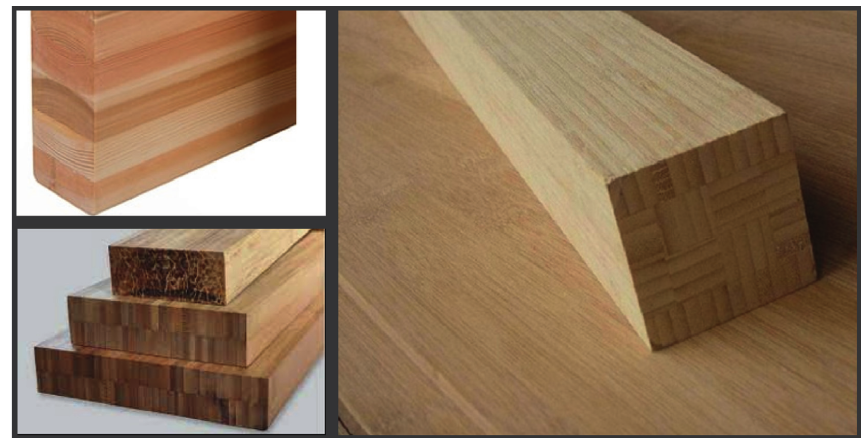
Figure 3: Engineered bamboo